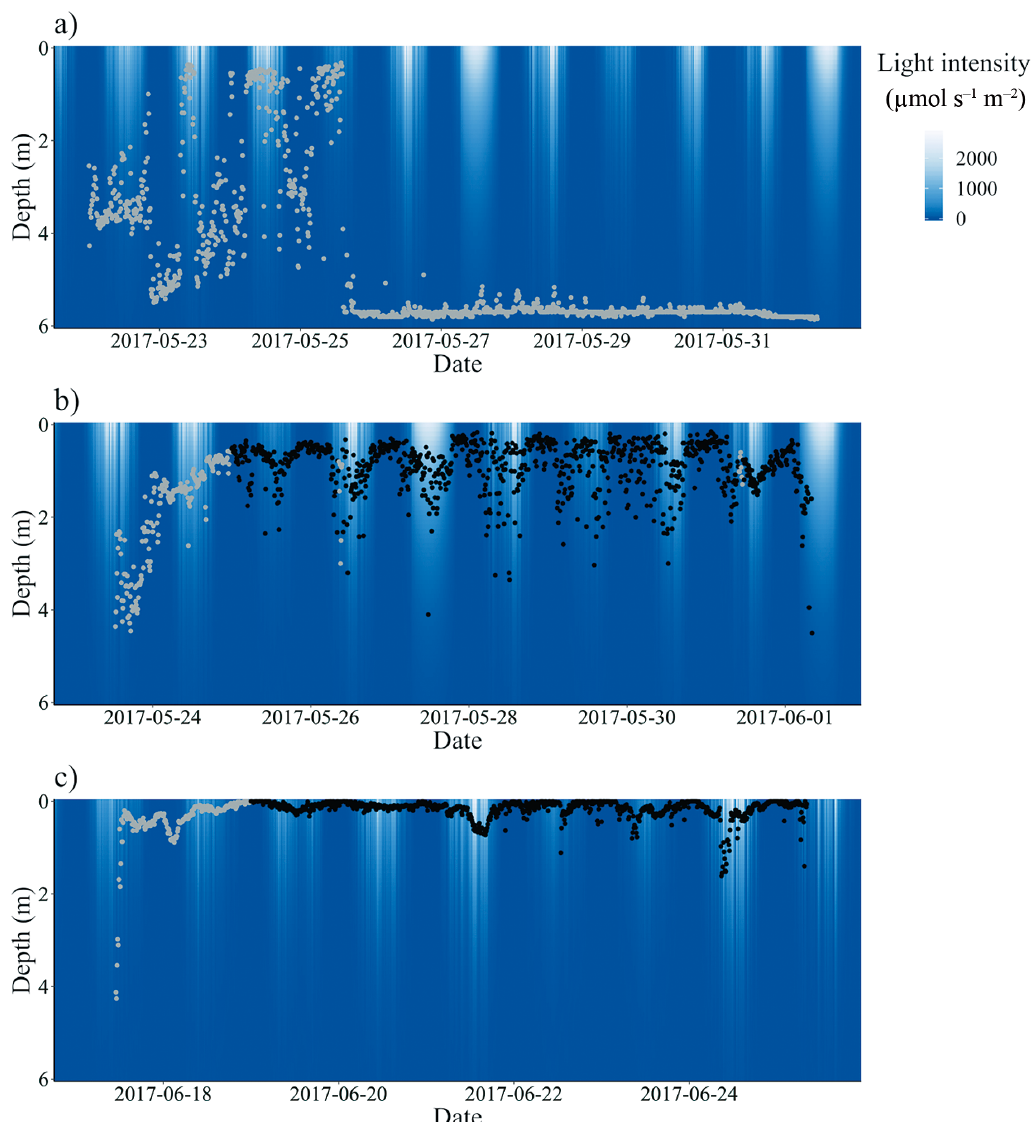
Fig. 2. Vertical distribution of Salmo trutta . Grey points represent data excluded from the analysis either due to mortality, re- covery period, or disturbances of the area. See details on data filtering in section 2.4. (a) Fish 210, (b) Fish 220, (c) Fish 419. See Table 2 for more details on the individual